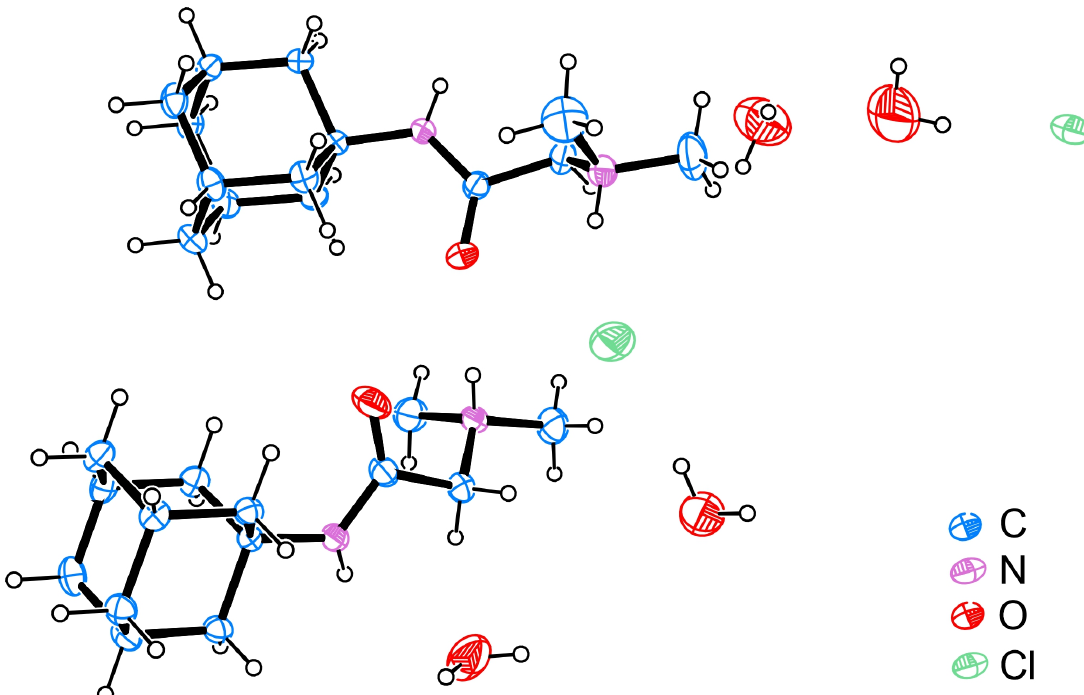
Figure 1. ORTEP [32] view of the molecules present in the asymmetric unit of DMG-Am; the thermal ellipsoids are drawn with 50% probability, hydrogen atoms are shown as small spheres with arbitrary radii. Figure 2). The first endothermic peak (55.63 °C) is associated with the release of water molecules. The second endothermic peak is associated with the melting of compound 1; the last peak is the decomposition. The second and third endothermic peaks with maxima at 228 °C and 240 °C, respectively, overlap, but the melting is observed as a sharp peak, while the decomposition is more prolonged. The DSC data for Am are shown in Figure 3.